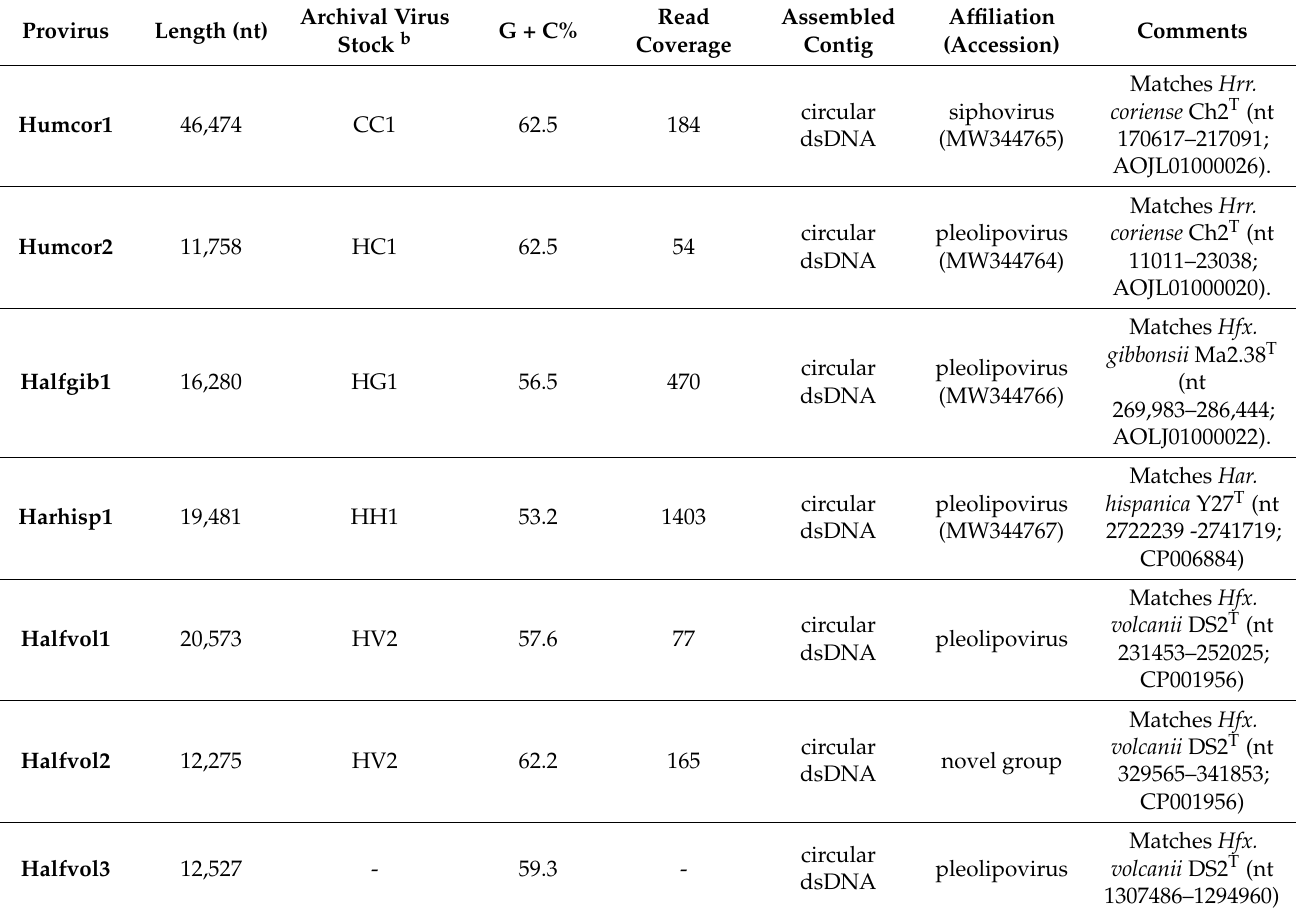
Table 6. Induced proviruses present in archival virus stocks a